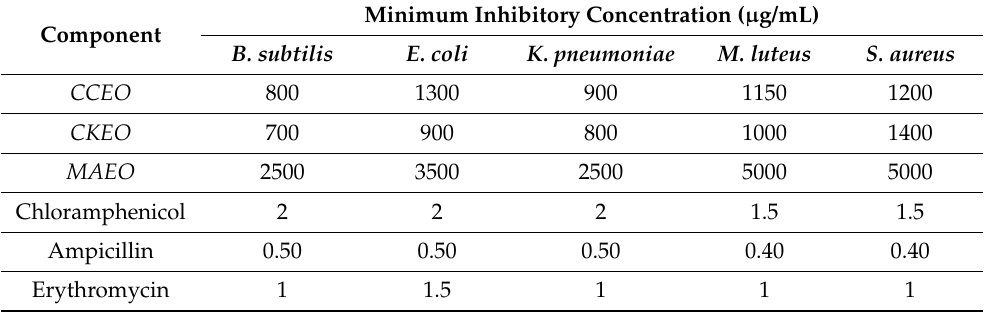
Table 2. Minimum inhibitory concentration of essential oils against different bacterial